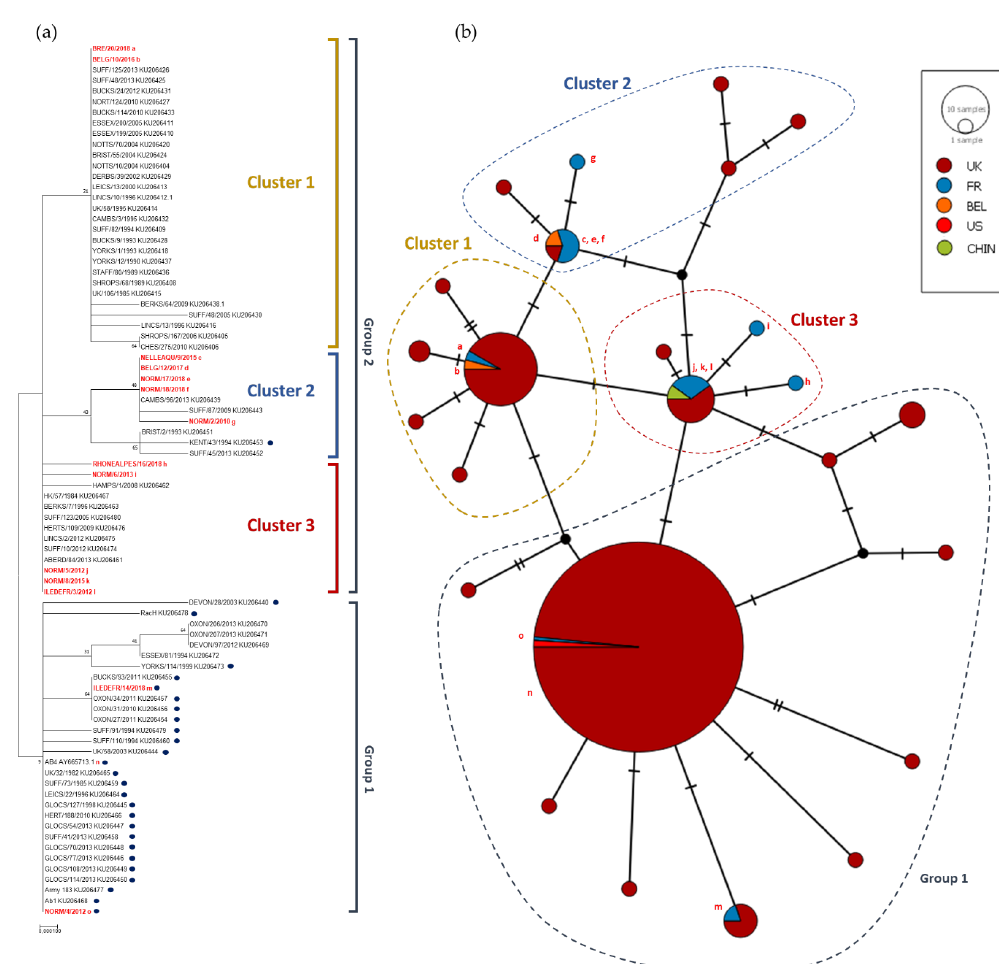
Figure 3. (a) Maximum Composite Likelihood method and Tamura-Nei matrix model phylogenetic tree based on ORF30 nucleotide sequences. Eighty-two strains including 14 strains isolated in France and Belgium from 2009 to 2018 (red bold text), 67 strains sequenced by Bryant et al. (2018) [14], and reference strain AY665713 (Ab4) are represented in this tree. Dots represent strains with the neuropathogenic type (G 2254 ). Boostrap values after 1000 replication are indicated at major nodes. (b) Median Joining Network based on the same ORF30 nucleotide sequences as for the phylogenetic tree.